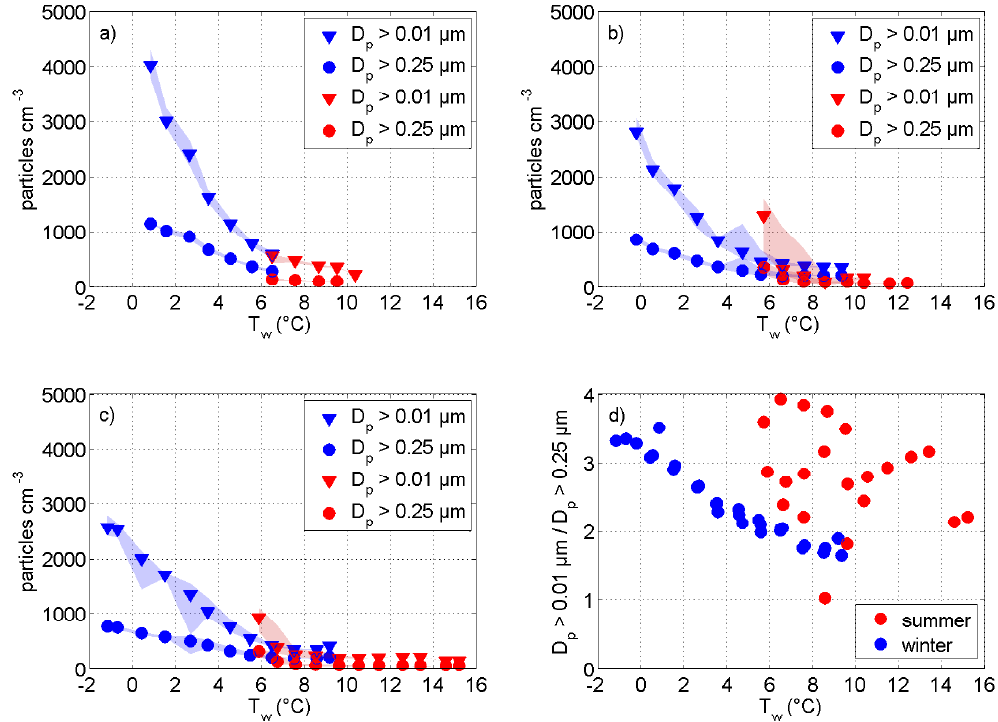
Fig. 3. The median particle number concentrations as a function of water temperature ( T w ). Blue data points represent winter data and red data points summer data with triangles for particles D p > 0 . 01µm and circles for particles with D p > 0 . 25µm. Blue and red shaded areas represent the interquartile ranges. Particle number concentrations are the result of bubble bursting in (a) deep fjord water, (b) water sampled close to glacier, (c) water sampled at the fjord mouth and (d) the ratio between particle number concentration of particles D p > 0 . 01µm and D p > 0 . 25µm. The ratios were built for each data point pair shown in (a–c) .